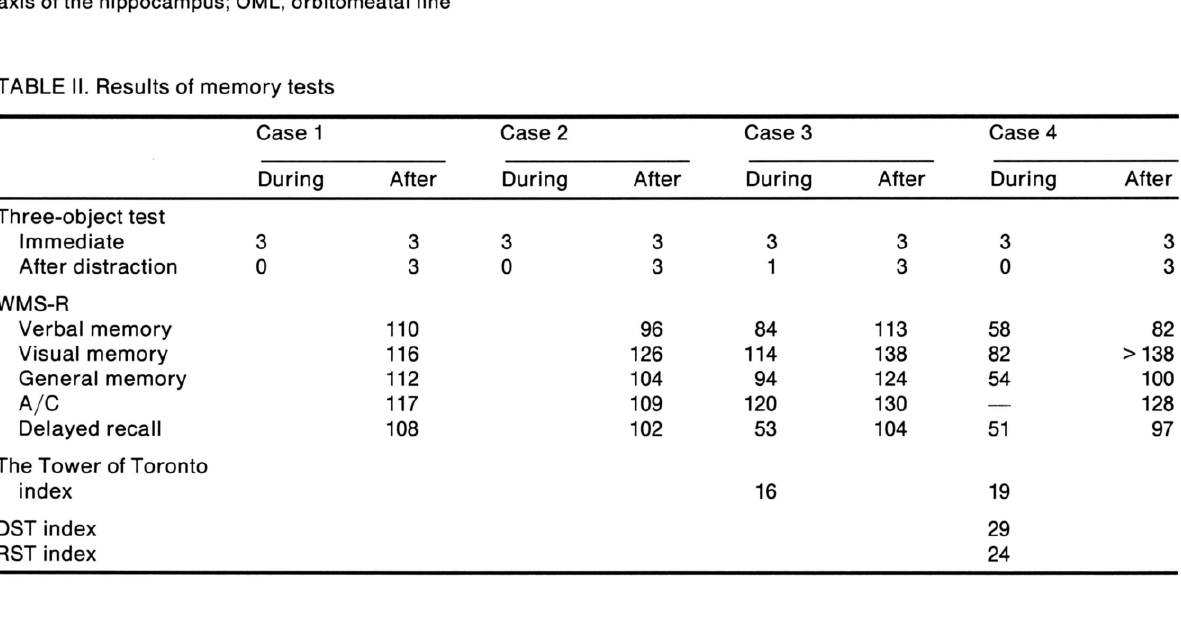
FIG. 2. Parasagittal MR image through the length of the hippocampal formation. H. hippocampus; HL. hippocampal line. long axis of the hippocampus; OML. orbitomeatal line